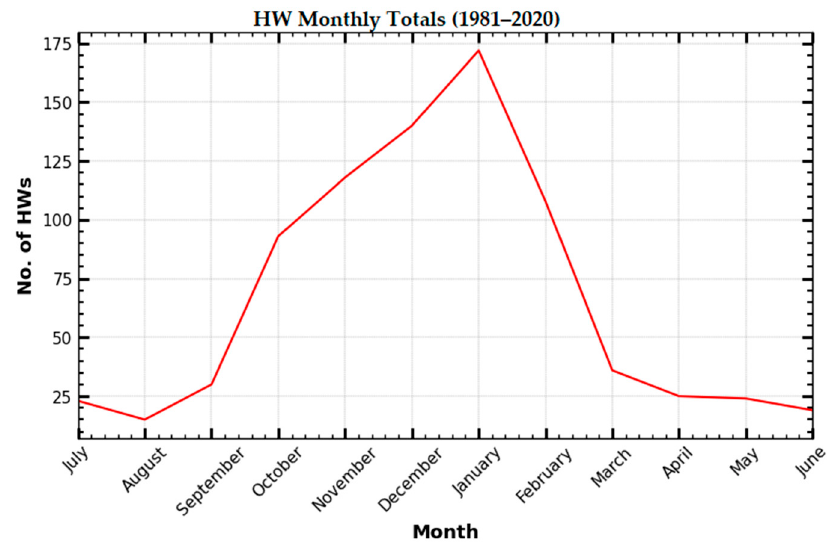
Figure 4. Monthly totals of HW frequency (red line) over South Africa from 1981 to 2020 from the 24 selected stations. The peak in January is clearly discernible. Table 3. The monthly HW frequency from 1981–2020 from the 24 selected stations.